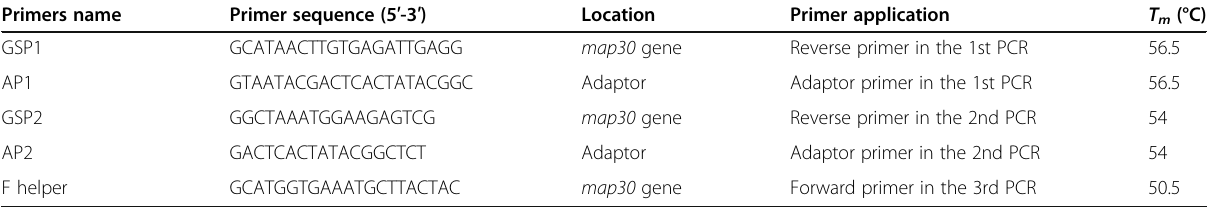
Table 1 Primers used in this study